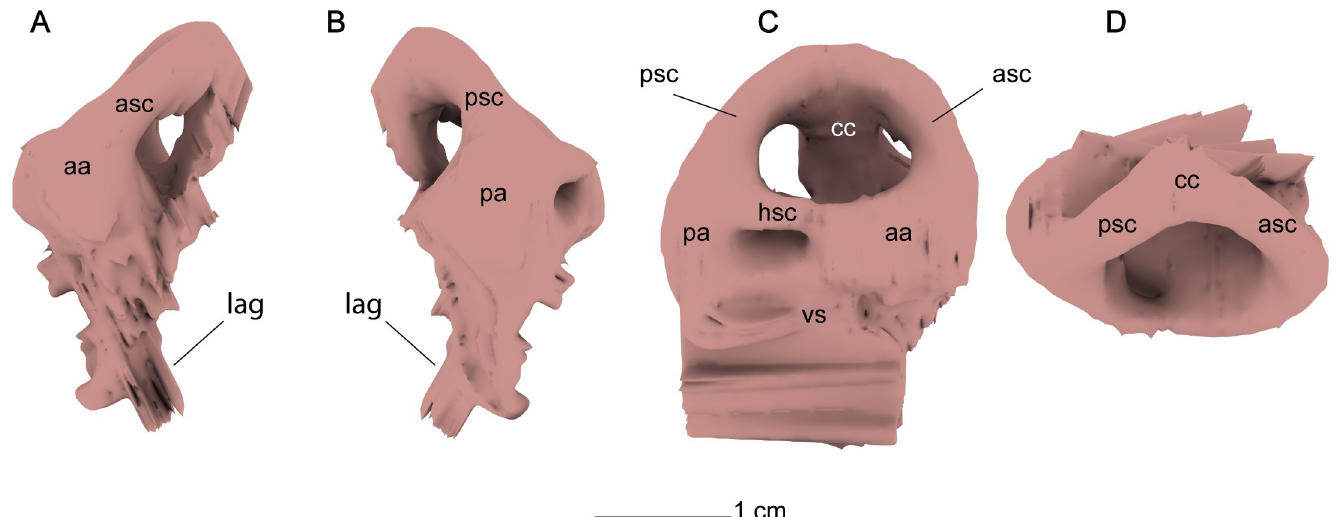
Fig 13. Endosseous labyrinth digital cast of Cardiocorax mukulu (MGUAN PA278). A. Anterior view. B. Posterior view. C. Ventral view. D. Dorsal view.